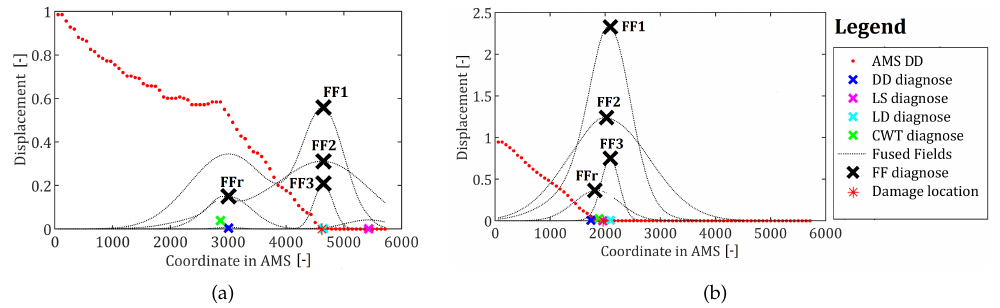
Figure 14. The results of all the damage detection methods for ( a ) damage located in a vertical bar and ( b ) damage located in a horizontal bar. The coordinate in AMS axis refers to the markers positions’ in a transformed space. The beginning of mapping started at a free end of the